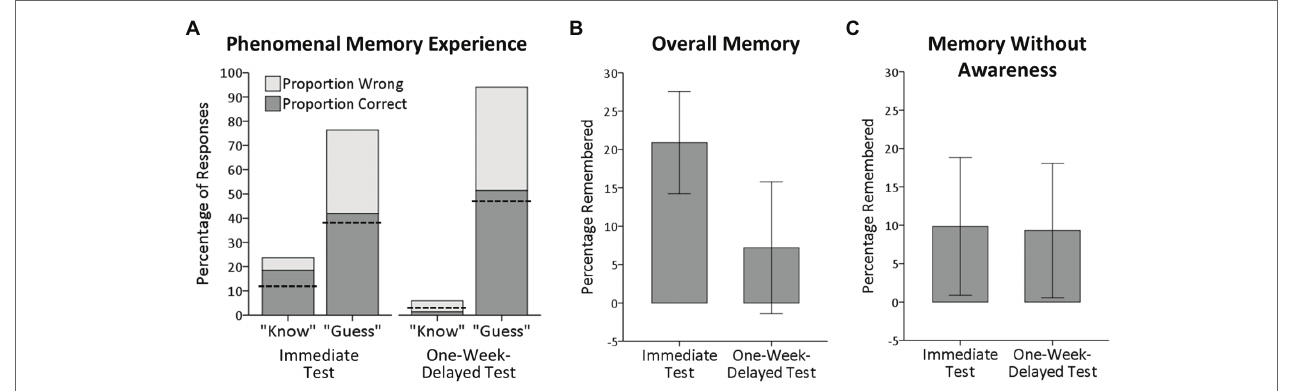
FIGURE 2 | (A) Phenomenal memory experience and objective memory performance. The total height of the bars shows the percentage of tested positions for which participants claimed to have (“know” responses) or have no (“guess” responses) phenomenal memory experience in the immediate and the 1-week-delayed memory tests. The dark gray bars show the proportion of correct memory responses (choosing the previously read page) and the light gray bars show the proportion of wrong memory responses (choosing the page with a word replaced by a synonym). The dashed lines indicate chance performance. (B) Overall memory performance. The height of the bars shows the percentages of words that were overall remembered (corrected for fortunate guesses) in the immediate and the 1-week-delayed memory tests, independently of participants’ phenomenal memory experience. (C) Memory without awareness. The height of the bars shows the percentages of words that were remembered on memory test trials where participants reported to have no phenomenal memory experience (“guess” trials) in the immediate and the 1-week-delayed memory tests (corrected for fortunate guesses). Error bars represent one-tailed 95% confidence